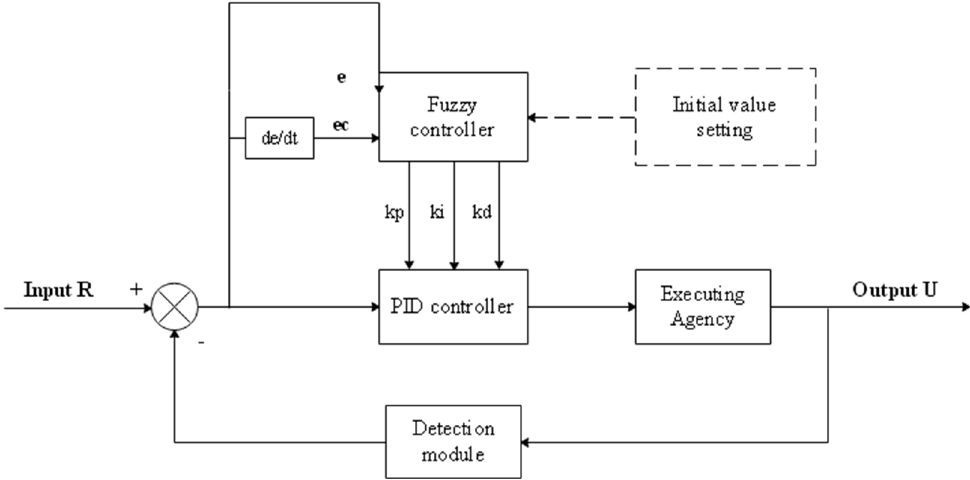
Figure 4. Schematic diagram of the fuzzy PID controller structure.